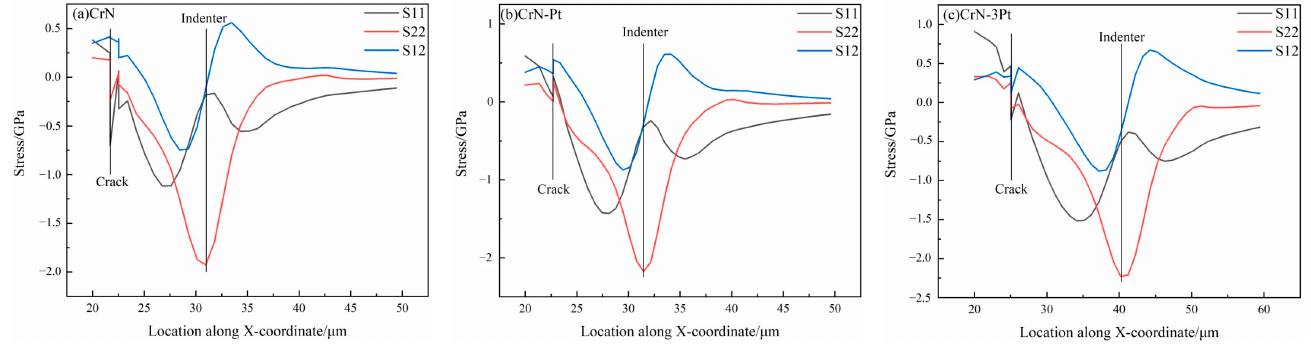
Figure 8 . Anisotropic stress distribution at the crack tip of three coatings when the crack propagates to half of the coating thickness. ( a ) CrN; ( b ) CrN-Pt; ( c ) CrN-3Pt.